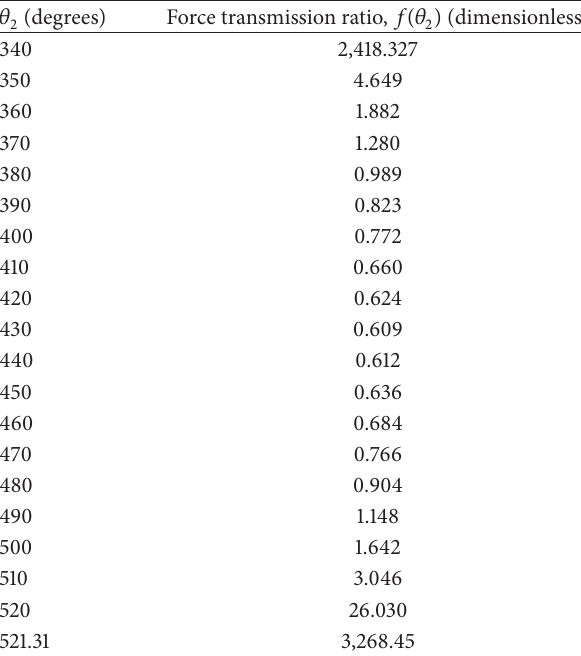
Table 2: Sample values of force transmission ratio during the crush- ing stroke.